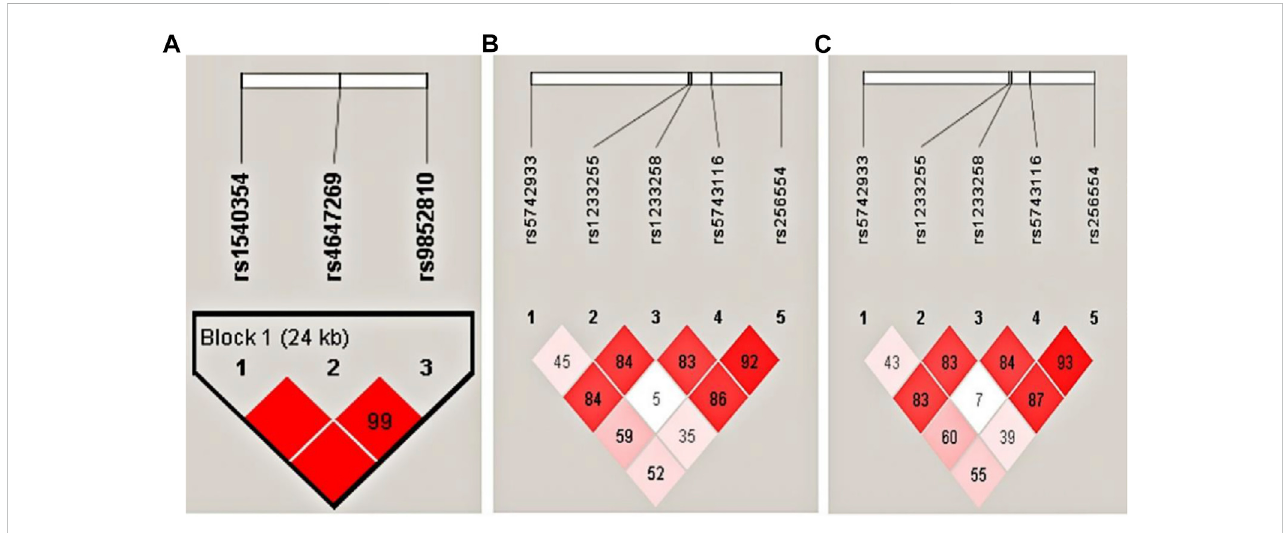
FIGURE 1 Haplotype analysis for MLH1 and PMS1 in NeC vs. HLD, SC vs. HLD and CHB + LC vs. HCC groups by Haploview4.2. (A) Three SNPs of MLH1 in NeC vs. HLD, SC vs. HLD and CHB + LC vs. HCC groups; (B) . Five SNPs of PMS1 in NeC vs. HLD and SC vs. HLD groups; (C) . Five SNPs of PMS1 in CHB + LC vs. HCC group. This Figure was generated using our sample population. The color ranges from white to red, representing the linkage degree from low to high. The values in boxes are D ’ values, the larger the value is, the higher the degree of linkage between loci is.